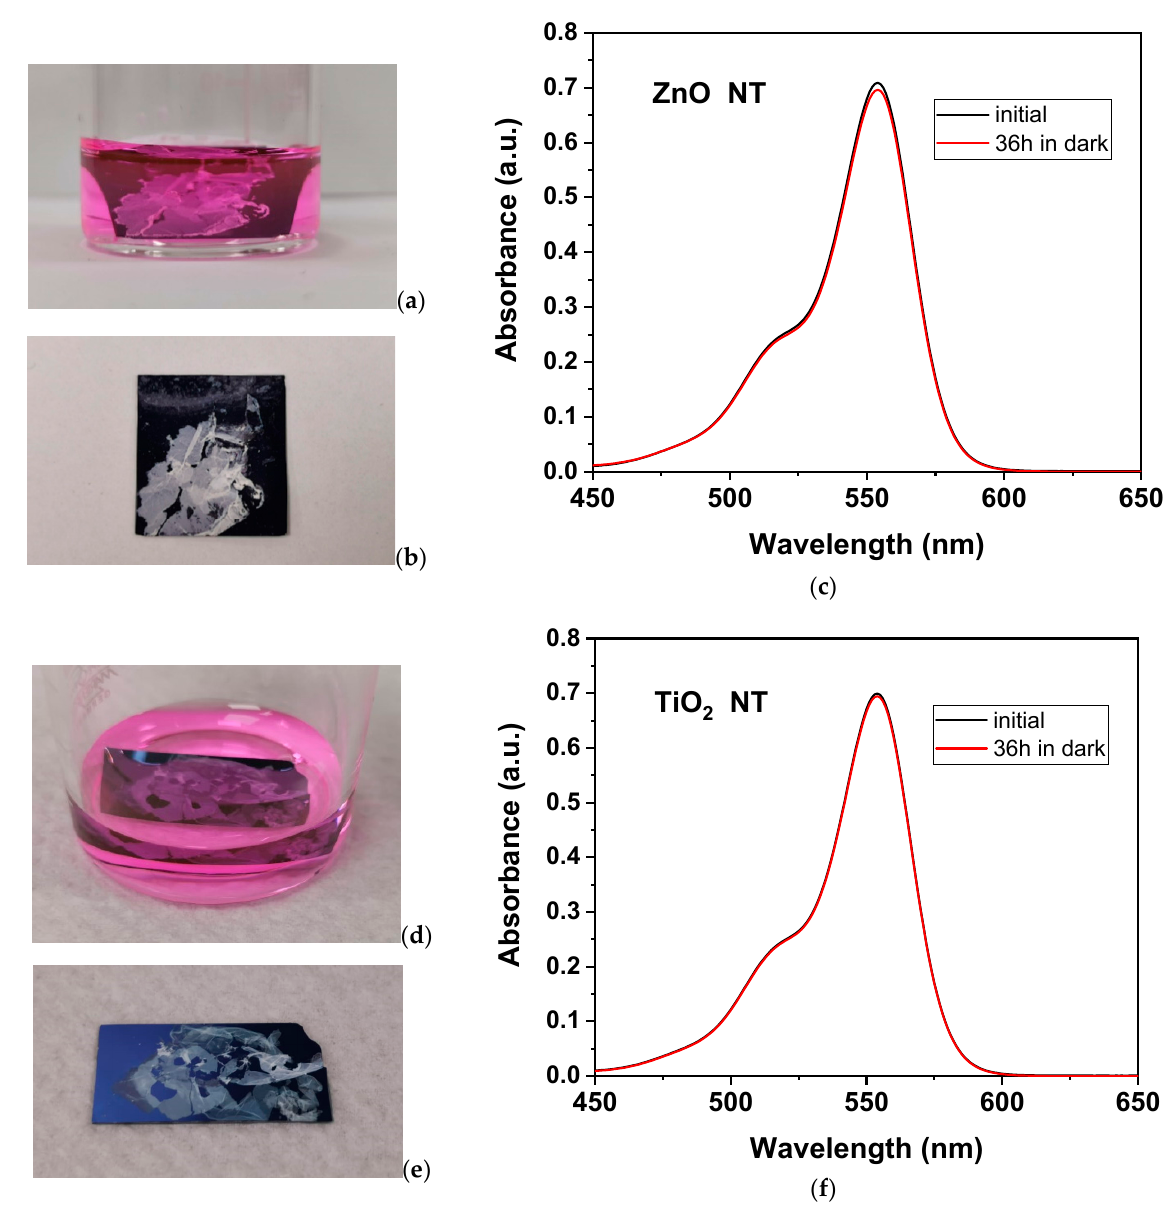
Figure 8. ( a ) ZnO NT inserted in RhB solution; ( b ) sample of ZnO NT on Si substrate after removal from RhB solution in which was kept in dark for 36 h; ( c ) initial and after 36 h spectra of RhB solution in which ZnO NT was immersed; ( d ) TiO 2 NT inserted in RhB solution; ( e ) sample of TiO 2 NT on Si substrate after removal from RhB solution in which was kept in dark for 36 h; ( f ) initial and after 36 h spectra of RhB solution in which TiO 2 NT were immersed.